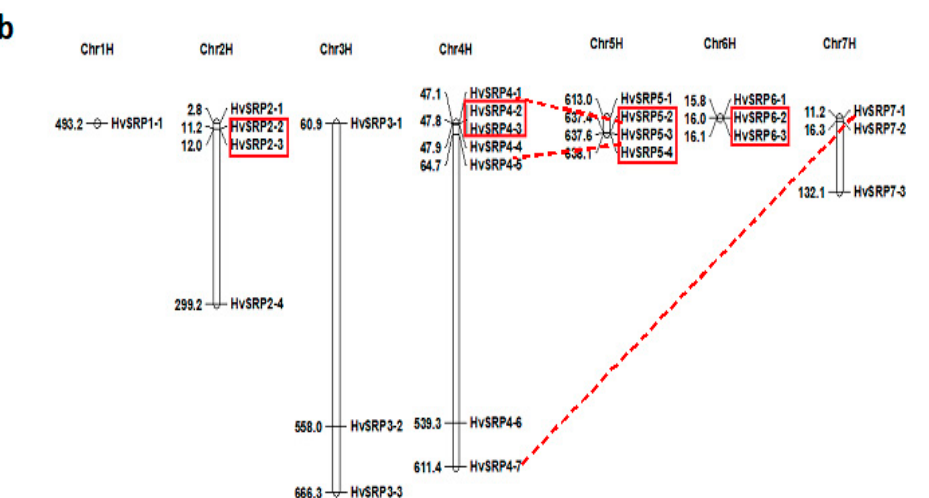
Figure 1. Chromosomal distribution of serpin genes in Brachypodium (Bd21) ( a ) and barley ( b ). Tandem duplicated genes are shown in boxes, and the segmentally duplicated genes are connected by dashed lines.